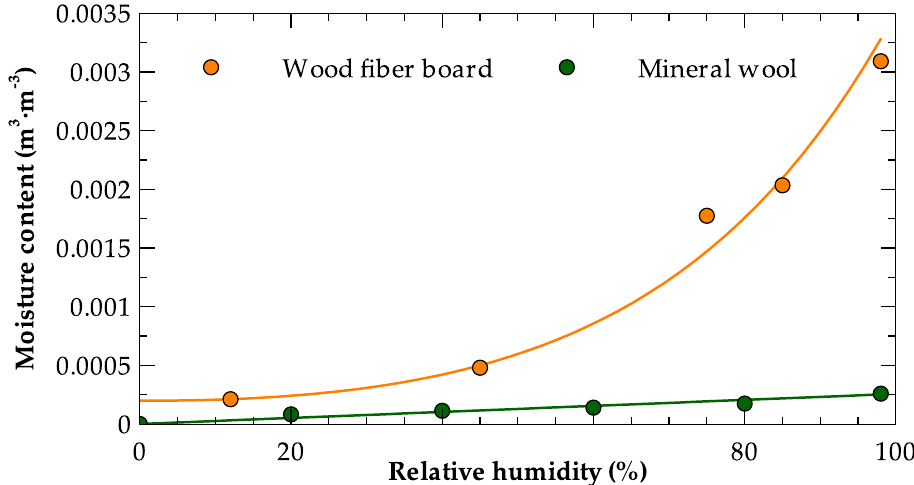
Figure 7. Water vapor storage properties of thermal insulations.